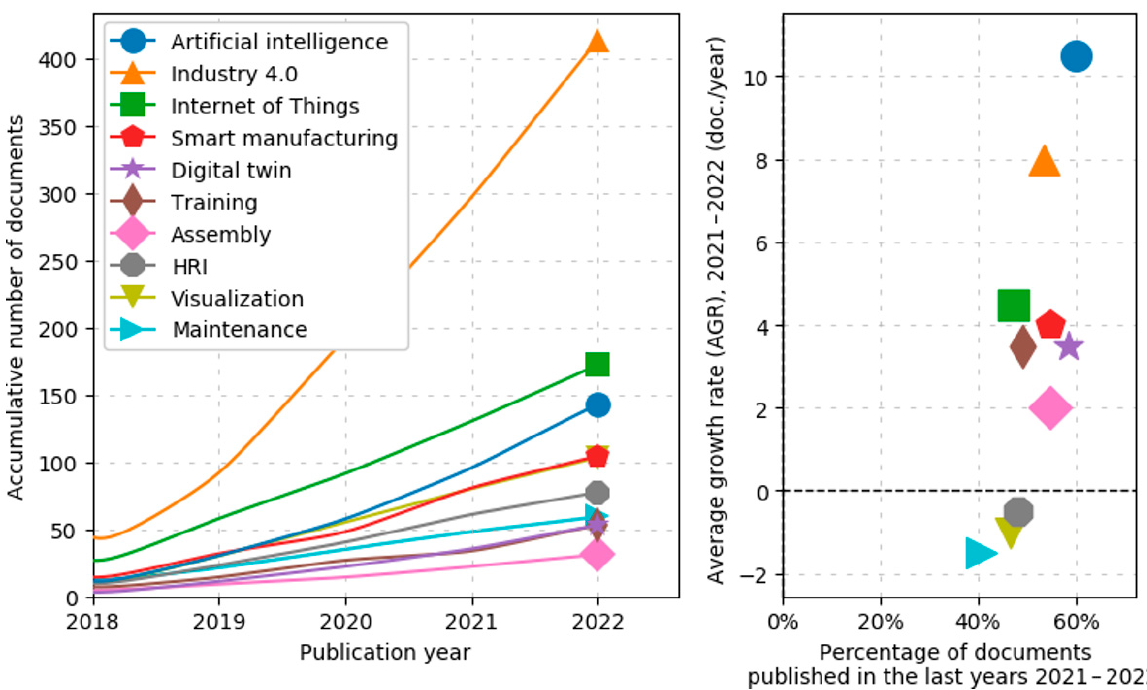
Figure 1. Top trending topics related to industrial augmented reality. The values of these parameters are reflected in Table 1. The evolution plot (see Figure 1) shows that trending topics have a consistent growth in the specified timeframe. For each trending topic, the AGR between 2021 and 2022 is shown on the Y axis of Figure 1 right diagram, and the PDLY is shown on the X axis. “Industry 4.0” is the trending topic with the most documents, while “artificial intelligence” is the topic with the fastest rate of growth. Table 1. Trend indices of selected